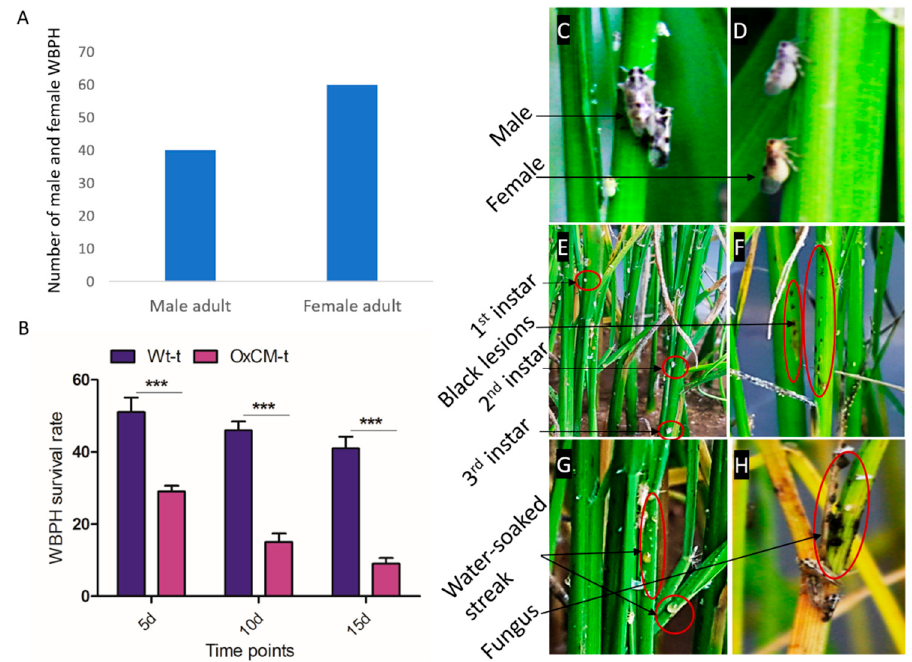
Figure 1. White-backed planthopper (WBPH) survival rate, their attack approach and symptoms on plant. ( A ) A total of 100 WBPH were infested out of them, 40 were male and 60 were female. ( B ) Rate of survival of WBPH on both wild-type plants infected with WBPH (Wt-t) and chorismate mutase transgenic over-expressor plants infected with WBPH (OxCM-t) after 5, 10, and 15 days of infestation. ( C , D ) Male and female respectively, feeding on seedling stem. ( E ) Identification of 1st, 2nd, and 3rd instar of WBPH life cycle. ( F – H ) Different symptoms of WBPH infestation, such as black lesion, green-yellow water streak, and fungal infestation respectively. Graph bars indicate the mean ± standard deviation ( n = 3), and asterisks indicate significant differences (*** p < 0.001) analyzed using two-way analysis of variance and Bonferroni post hoc test. Data presented in graphical form are the means for three independent experiments.